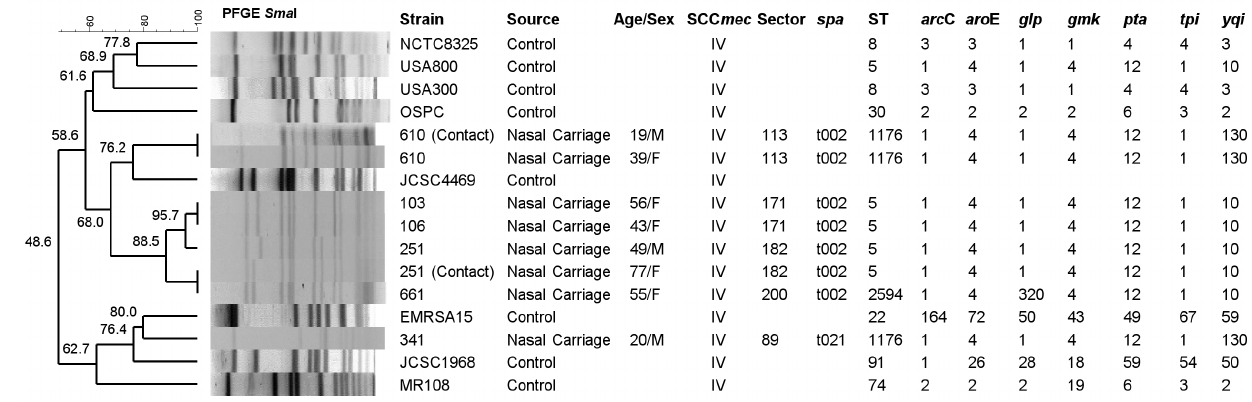
Figure 1. Dendrogram showing Pulsed Field Gel Electrophoresis typing of the study isolates, alongside with results from Multilocus Sequence Typing and spa typing. International SCCmec type IV clones are included as controls. Note. Data on age/gender and urban area typing are included. Control strains were kindly provided by Dr. Antonio Carlos Campos Pignatari (Universidade Federal de Sa˜o Paulo, City of Sa˜o Paulo, Sa˜o Paulo State, Brazil) and Dr. Agnes Marie Sa´ Figueiredo (Universidade Federal do Rio de Janeiro, City of Rio de Janeiro, Rio de Janeiro State, Brazil).